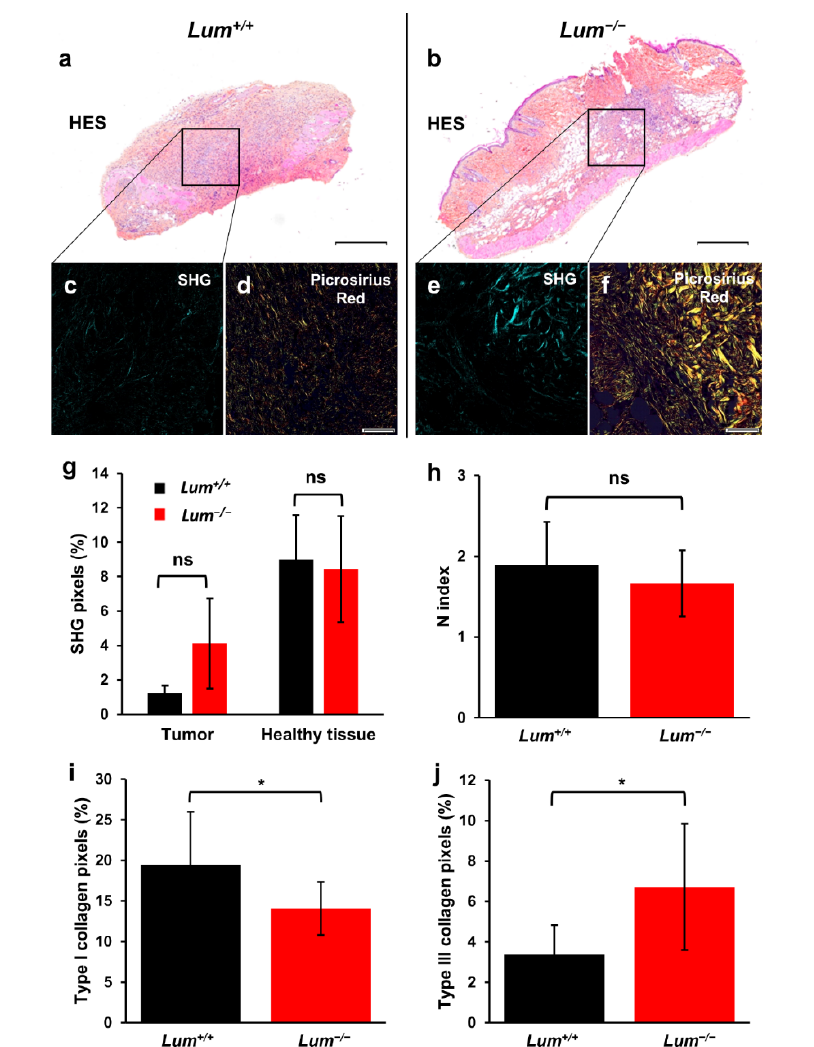
Figure 4. Analysis of collagen organization in ovarian tumor sections of wild-type and lumican- deficient mice. ( a , b ) Representative microphotographs of s.c. allograft sections stained with HES (top panel, original magnification 20×, scale bar 500 µm) in Lum +/+ ( a ) and Lum − / − mice ( b ); ( c – f ) Picrosirius red and SHG image analyses of ovarian allografts in tumors implanted in Lum +/+ mice ( c , d ) and in tumors from Lum − / − mice ( e , f ); ( c , e ) Collagen SHG images from ID8 ovarian tumors (original magnification 20×); ( d , f ) Ovarian tumor sections stained with Picrosirius red and viewed under widefield cross-polar optics (original magnification 20×, scale bar 50 µm). Birefringence of collagen fibers allows distinction between type I (red) and type III (green) collagens; ( g ) Analysis of collagen fibers intensity by SHG in tumors and healthy tissues present in each section (mean ± SD, ns: not significant); ( h ) Analysis of tumor ECM collagen organization from images derived from Gabor filtering and FFT, processed on Picrosirius red images (mean ± SD, ns: not significant); ( i ) Quantifica- tion on Picrosirius red stained sections of the relative distribution of red pixels (corresponding to type I collagen) in tumor ECM of Lum +/+ and Lum − / − sections (mean ± SD, * p < 0.05); ( j ) Quantification on Picrosirius red stained sections of the relative distribution of green pixels (corresponding to type III collagen) within tumors of Lum +/+ and Lum − / − sections (mean ± SD, * p <